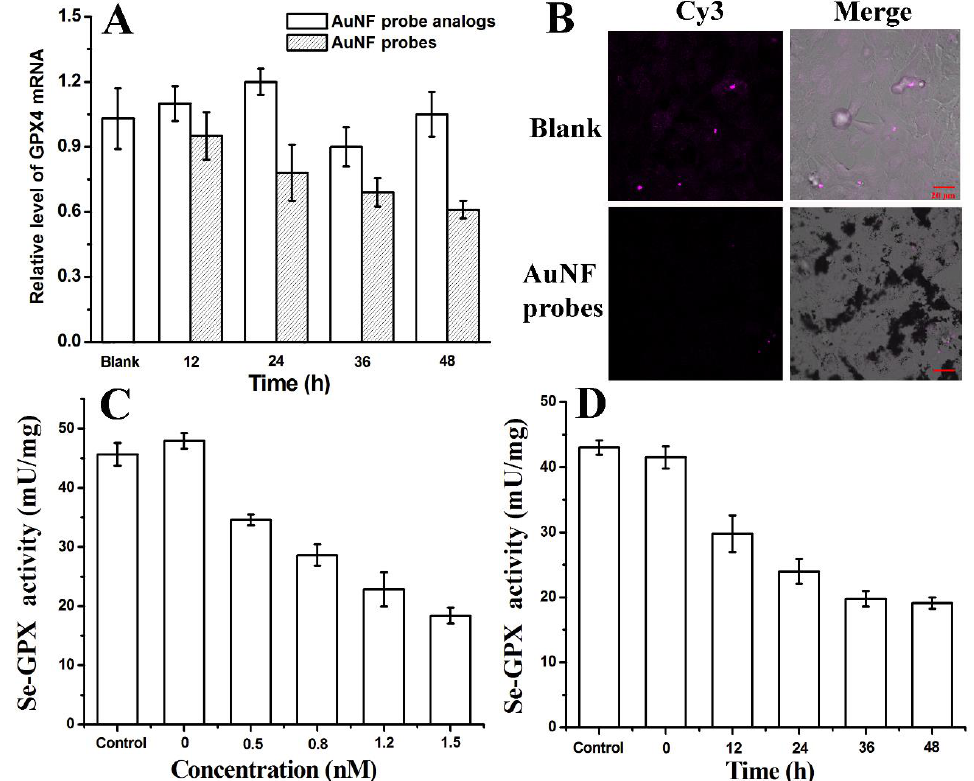
Figure 5. ( A ) qRT-PCR analysis of GPX4 mRNA in HeLa cells after being treated with AuNF probes (1.5 nM) or AuNF probe analogs (1.5 nM) for different times (12, 24, 36, and 48 h). ( B ) Immunofluorescence confocal imaging of GPX4 expression (purple) in HeLa cells after being treated with AuNF probes (1.5 nM) or PBS (Blank) for 48 h. ( C ) The activity of Se-GPX in HeLa cells after being treated with different concentrations of AuNF probes (0, 0.5, 0.8, 1.2, and 1.5 nM) for 48 h. ( D ) The activity of Se-GPX in HeLa cells after being treated with AuNF probes (1.5 nM) for different times (0, 12, 24, 36, and 48 h).